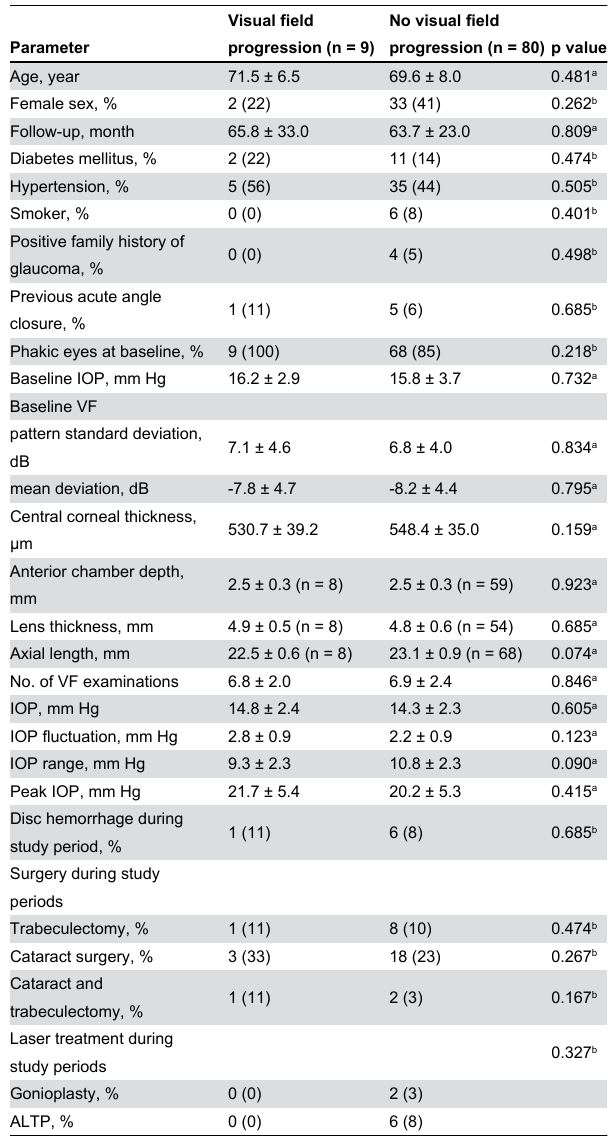
Table 1. Comparison of clinical characteristics between primary angle closure glaucoma with and without visual field